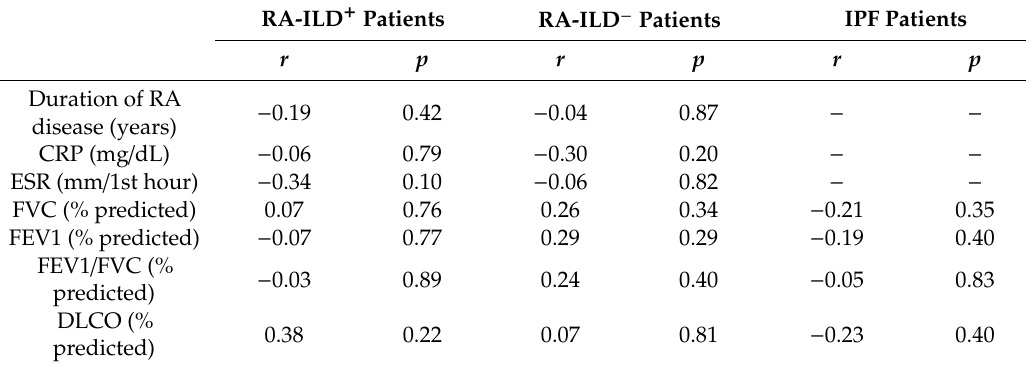
Table 2. Correlation of EPC frequency with continuous variables related to disease features.